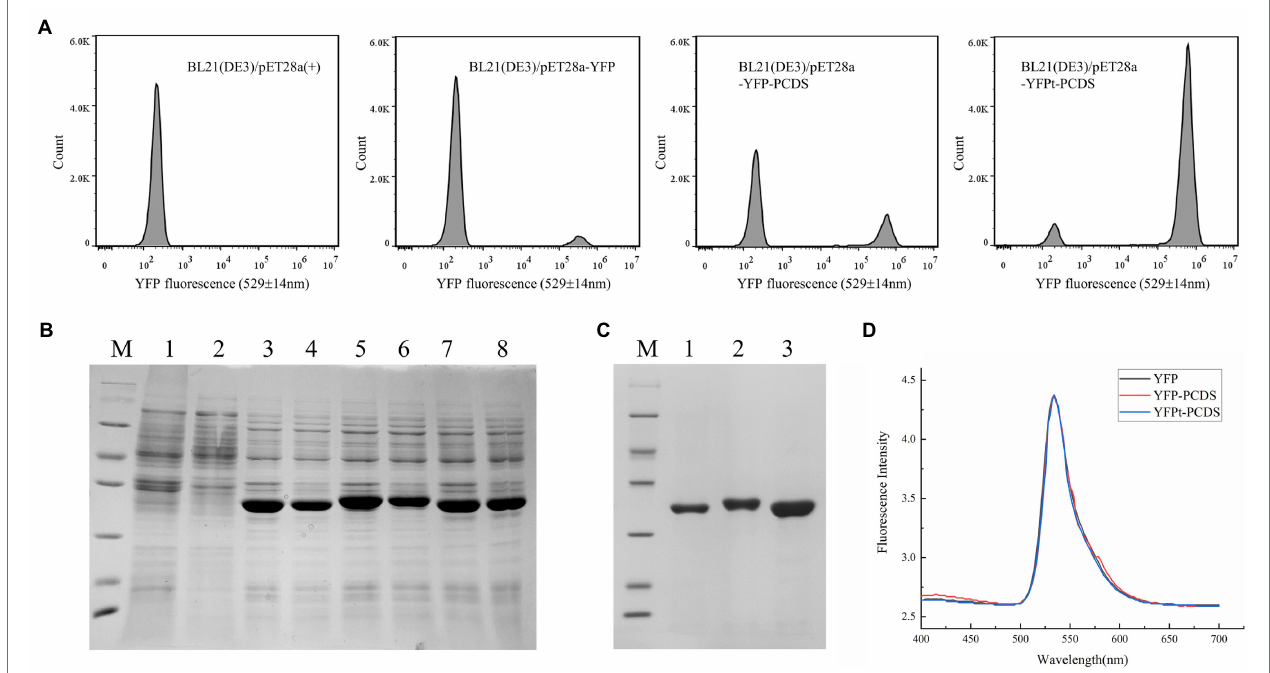
FIGURE 5 | Biochemical properties of recombinant His 6 -YFP, His 6 -YFP-PCDS, and His 6 -YFPt-PCDS. (A) Expression levels of BL21 (DE3)/pET-28a(+), BL21 (DE3)/ pET-28a-YFP, BL21 (DE3)/pET-28a-YFP-PCDS and BL21 (DE3)/pET-28a-YFPt-PCDS were analyzed by FACS. (B) Total cell extract and soluble cell extract from induced E . coli BL21(DE3). Lane M, protein molecular mass standards (Unstained Protein Molecular Weight Marker, No. 26610, Thermo Fisher Scientific, Waltham, MA, United States); lane 1, total BL21 (DE3)/pET-28a (+); lane 2, soluble BL21 (DE3)/pET-28a (+); lane 3, total BL21 (DE3)/pET-28a-YFP; lane 4, soluble BL21 (DE3)/ pET-28a-YFP; lane 5, total BL21 (DE3)/pET-28a-YFP-PCDS; lane 6, soluble BL21 (DE3) /pET-28a-YFP-PCDS; lane 7, total BL21 (DE3)/pET-28a-YFPt - PCDS; lane 8, soluble BL21 (DE3)/pET-28a-YFPt-PCDS. (C) Purified soluble protein. Lane M, protein molecular mass standards (Unstained Protein Molecular Weight Marker, No. 26610, Thermo Fisher Scientific, Waltham, MA, USA); lane 1,